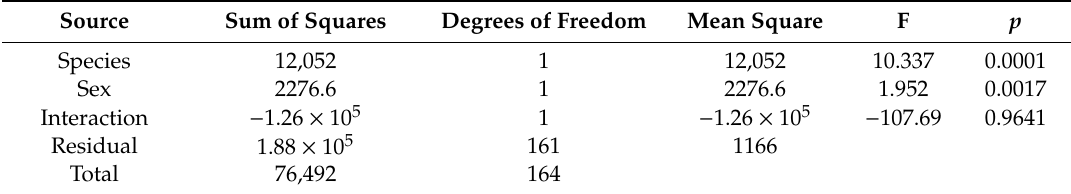
Table 1. Two-way NPMANOVA (Nonparametric Multivariate Analysis of Variance) for both species and sex for adult 15 mules (7 males and 8 females) and 150 adult horses (137 uncastrated males and 13 females): Analysis reflected significative di ff erences between sexes and species but not their interaction. F-test is the mean square for each main e ff ect and the interaction e ff ect divided by the within variance. The interaction e ff ect is the e ff ect that one factor has on the other factor.